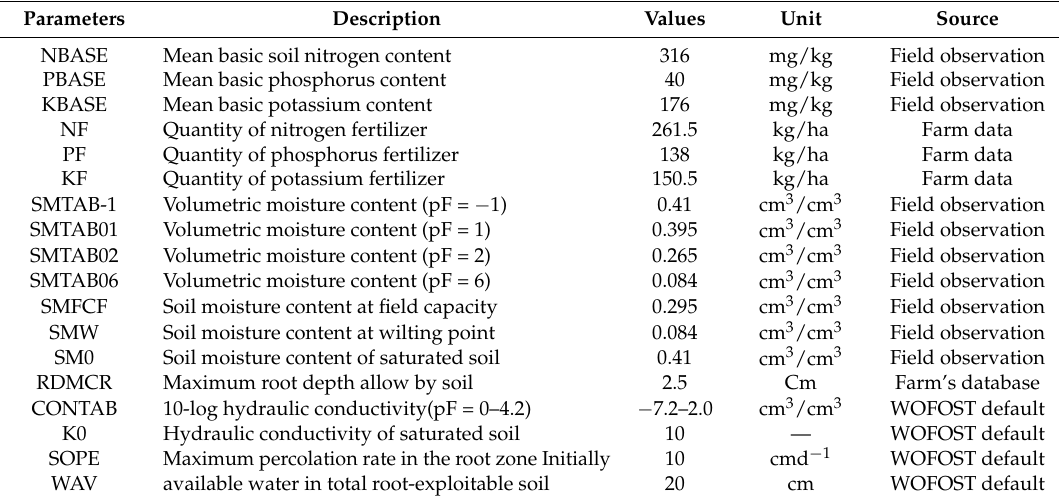
Table 5. Input soil parameters of the WOFOST model.